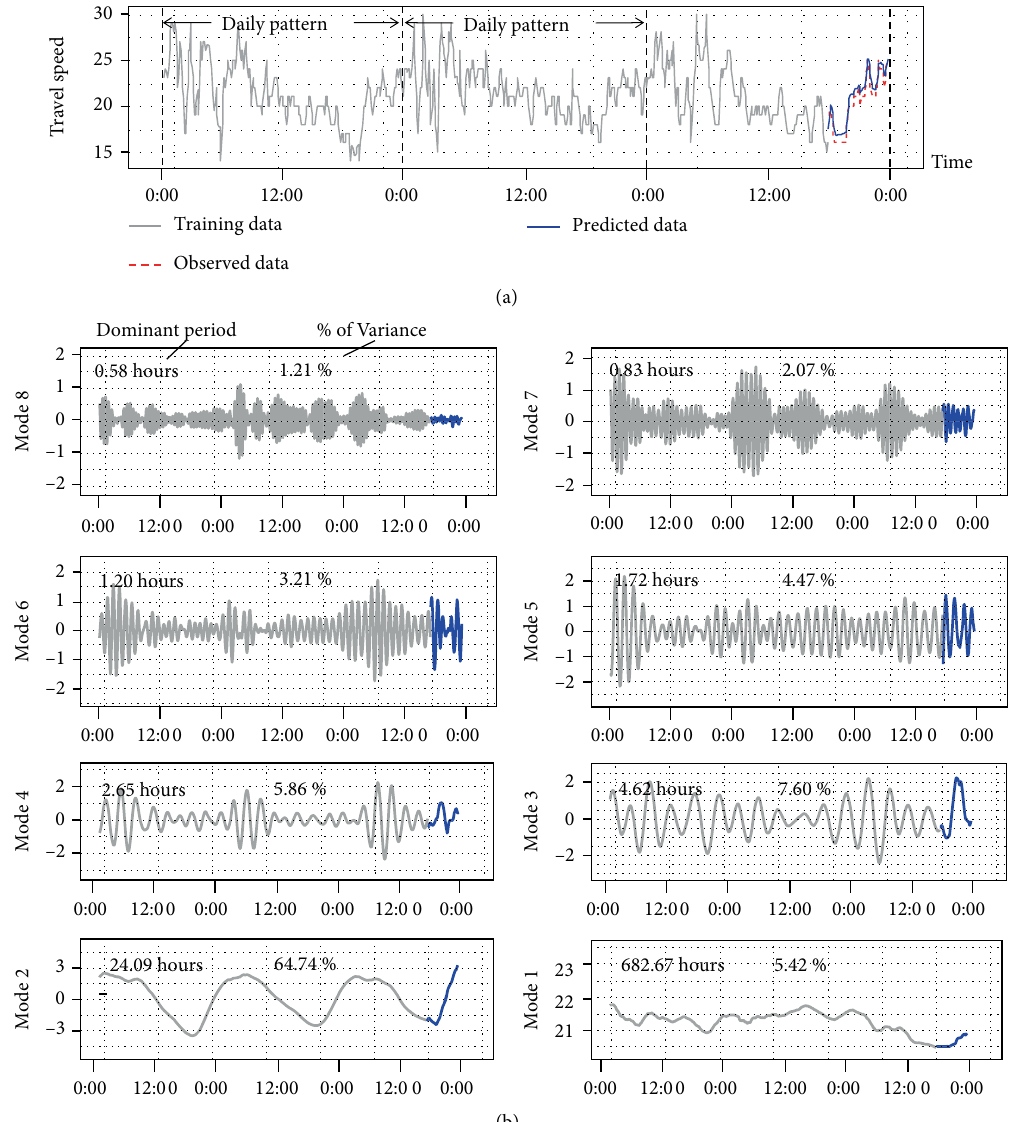
Figure 6: (a) Three days of travel speed data from Link 523; (b) Its corresponding decomposed modes with central